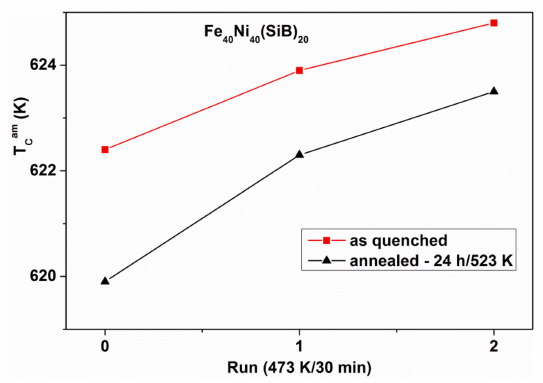
Figure 40. Comparison of the T Cam shift in Fe 40 Ni 40 Si 6 B 14 samples, being previously charged or not charged with hydrogen. Adopted from [87], with permission from BENTHAM Open,